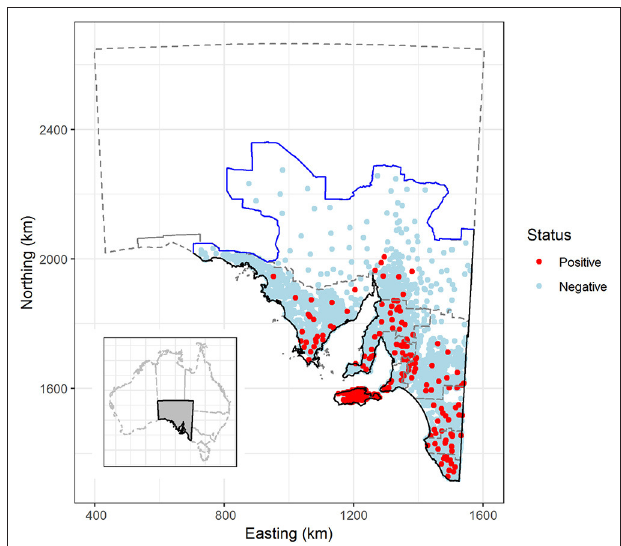
FIGURE 1 | Sarcocystosis-positive and negative sheep farms, based on sheep submitted to the Thomas Foods International slaughterhouses in South Australia, 2007–2017. Solid black line defines the extent of the study region; the solid blue line represents the dog fence and outlines the northern and western boundary of the study region; the gray dashed line outlines farm identification code regions and the South Australian state border. Farm locations have been jittered by 5km to obscure the identity of farm locations in remote areas. Insert—location of South Australia in relation to the remainder of Australia. Map projection EPSG: 3107 South Australian Lambert, GDA